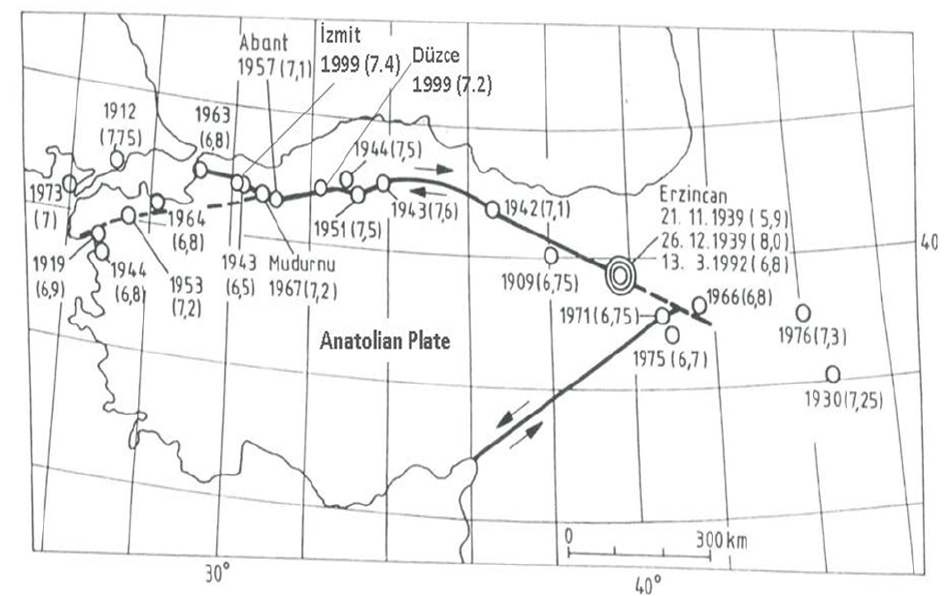
Fig. 2. The dates and magnitudes (in brackets) of major earthquakes along the NAFZ (modified from Altiner,